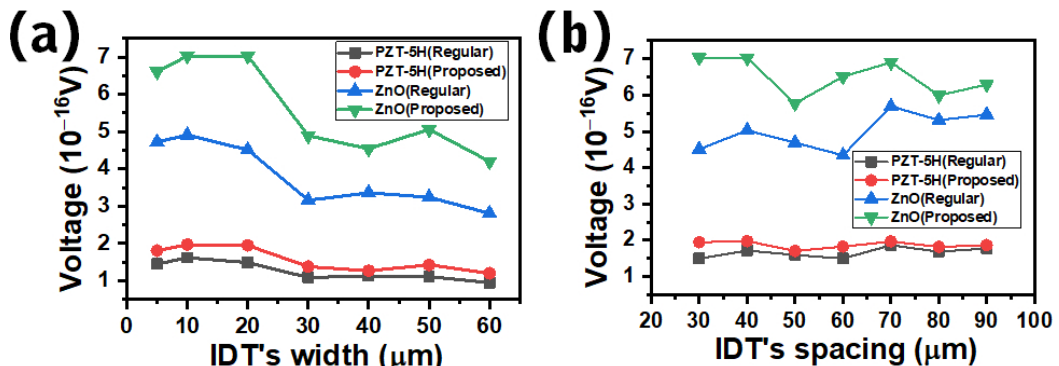
Figure 10. FEM simulations of unit cells of the regular and proposed D33 modes using PZT-5H and ZnO, ( a ) with varying IDT widths in a range of 5 µ m, 10 µ m, 20 µ m, 30 µ m, 40 µ m, 50 µ m and 60 µ m, and ( b ) with varying spacings between two adjacent IDTs in a range of 30 µ m, 40 µ m, 50 µ m, 60 µ m, 70 µ m, 80 µ m, and 90 µ m at an IDT width of 20 µ